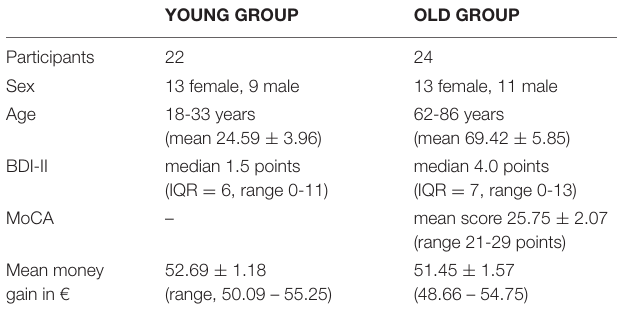
TABLE 1 | An overview of test person groups and